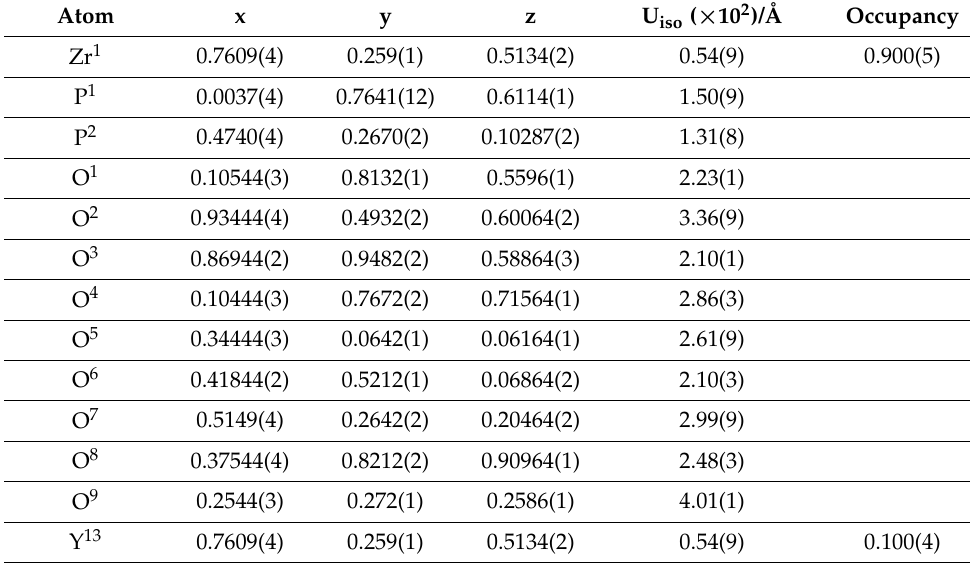
Table 8. Refined fractional atomic coordinates and isotropic thermal displacement parameters for hydrothermally synthesised 10%